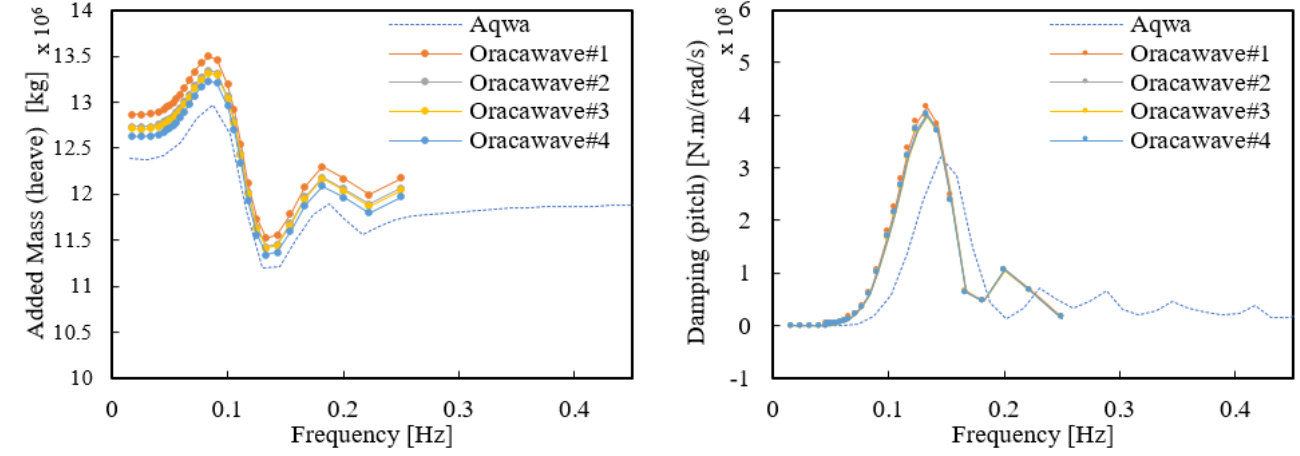
Figure 15. Four ‐ column platform hydrodynamic result (heave and pitch).